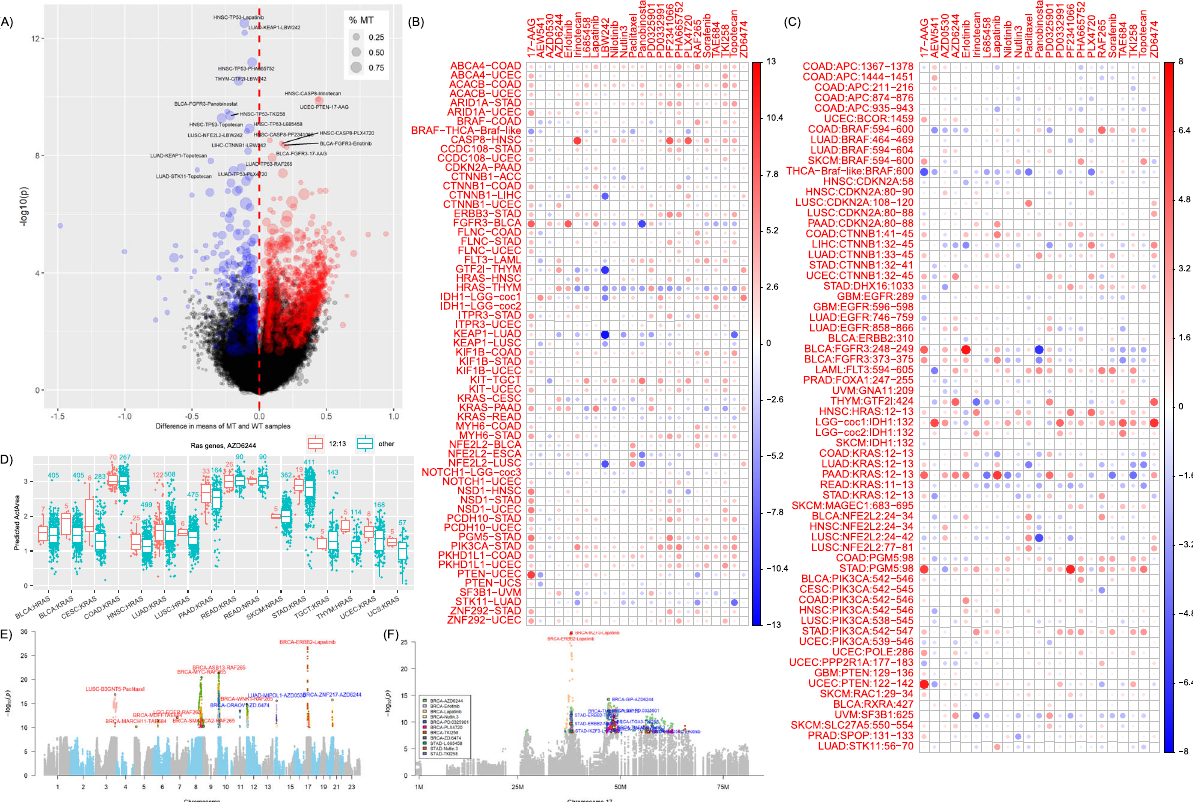
Fig. 7 Association of somatic mutations with drug response. A Volcano plot of drug – gene association. The genomic signature was de fi ned using the mutation status of each gene. Each dot represents the statistics of the association status of a gene in a cancer type with a drug. The P value was obtained from a two-sided Wilcoxon test comparing the predicted response in samples with the mutant gene (i.e., those with deleterious missense SNVs or nonsense SNVs) (MT) and samples with wild-type gene (WT). The former group was required to have at least ten samples. x axis: the difference of the average drug response in the samples harboring the mutated gene from that in the wild samples, y axis: − log10( P ) where the unadjusted p -value was used for plotting. Red (difference >0) and blue (difference <0) dots indicate signi fi cant associations (BH-adjusted P < 0.05). B Heatmap showing the signi fi cant drug – gene associations in each cancer type. Due to space limitation, only associations with adjusted P BH < 0.005 for positive association or P BH < 0.01 for negative association were plotted. Associations involving the gene TP53 were also excluded from plotting. The color and size of the circle in each cell is proportional to -log10( p ) (note that we used the unadjusted P value for plotting). C Heatmap showing the signi fi cant drug – gene associations determined by mutation clusters. Each cell represents a mutation cluster of a speci fi c gene in association with a speci fi c drug. The P value was obtained from a two-sided Wilcoxon test comparing the predicted response in samples with mutations in a mutation cluster (i.e., only deleterious missense SNVs or nonsense SNVs considered) and samples with wild-type gene. Similarly, the former group was required to have at least ten samples to allow more tested clusters. D Distribution of the response to drug AZD6244 in the samples with two mutation clusters of Ras genes. Only the cases that had fi ve or more mutated samples are shown. Each box shows the interquartile range (IQR between Q1 and Q3) for the corresponding set. The central mark (horizontal line) shows the median. E Association of drug response with copy number gain. F Association of drug response with copy number gain, focusing on chromosome 17 where ERBB2 was